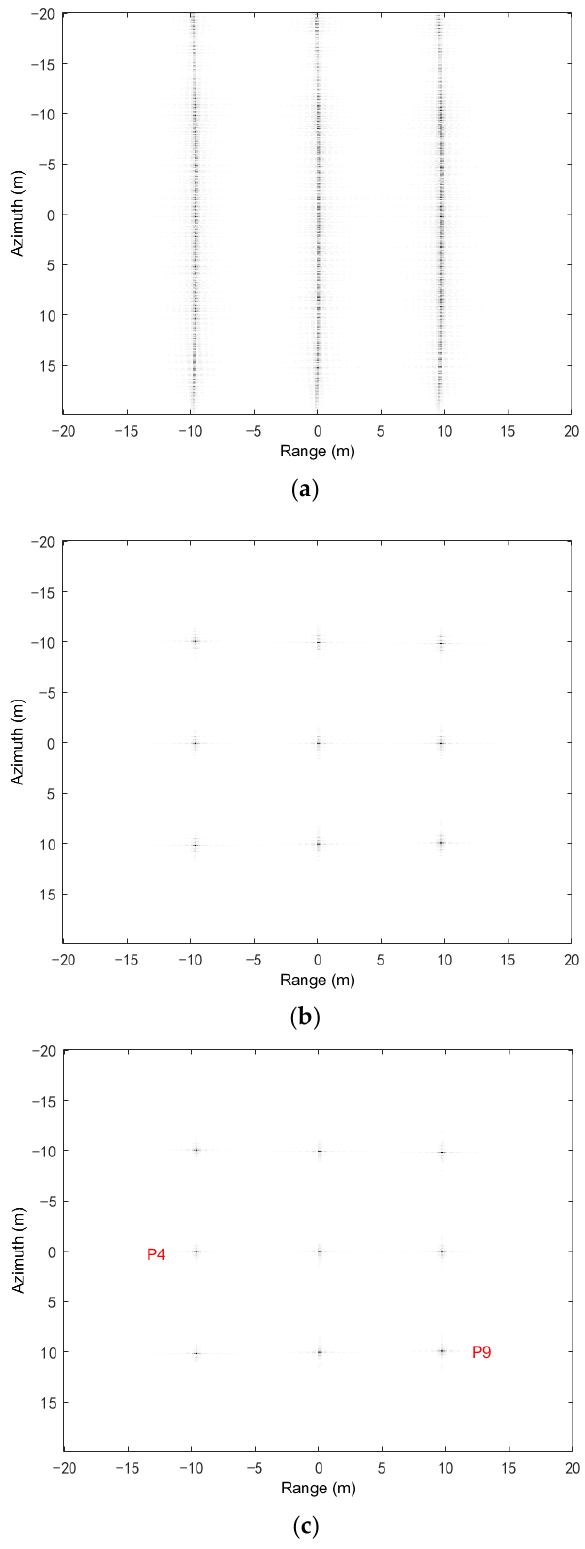
Figure 9. Imaging results. ( a ) Without compensation; ( b ) FrFT-QML-RANSAC; ( c ) Chirplet-LSSE-SRT. P4 and P9 are two selected points for further azimuth responses analyze.